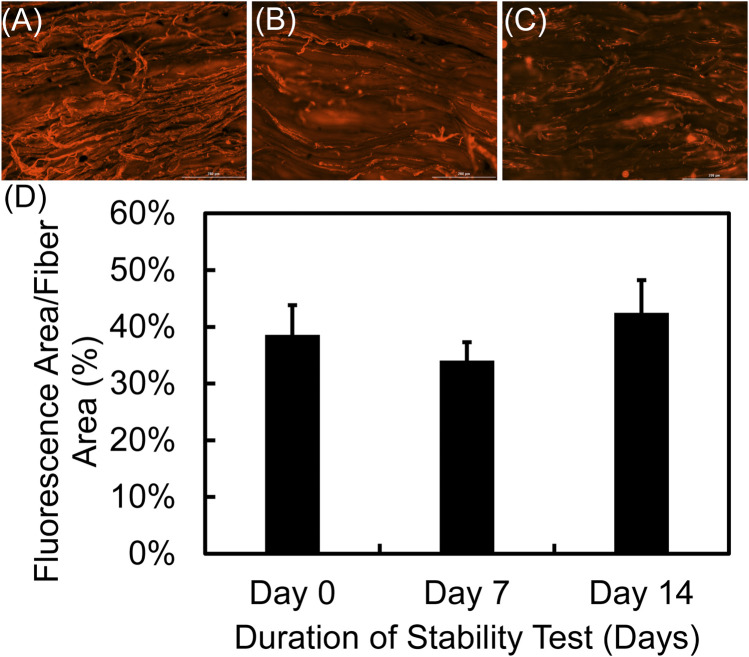
Qualitative and quantitative assessment of biotin in the PPy coating over 14 days. Fluorescent images show Alexa Fluor™ 350 conjugated streptavidin bonded to available biotin in the PPy coating after (A) 0 (B) 7, and (C) 14 days of incubation in phosphate buffered saline at 37 °C (D) The fraction of fiber area that was fluorescent was quantified over the 14 days observation period and indicated no significant change over time (p = 0.428).